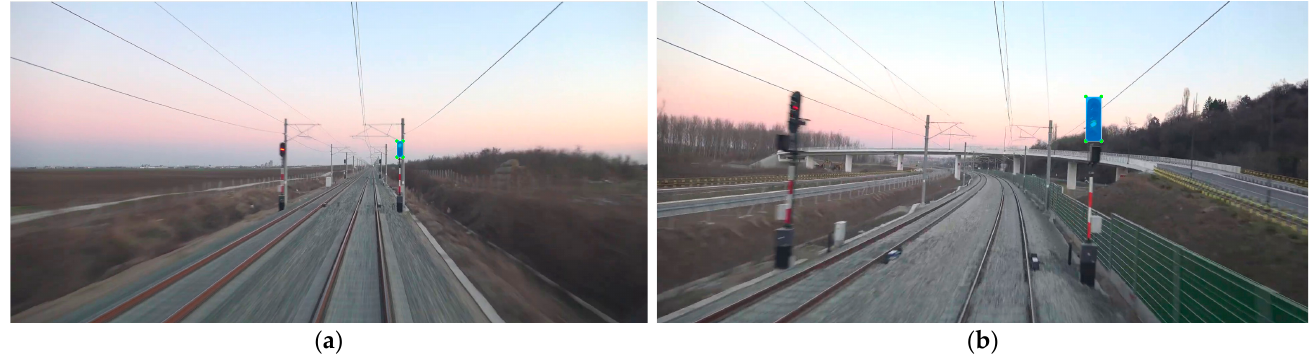
Figure 11. Labeled images—Rectangle method. ( a ) Signal relatively far from the camera; ( b ) signal relatively close to the camera.